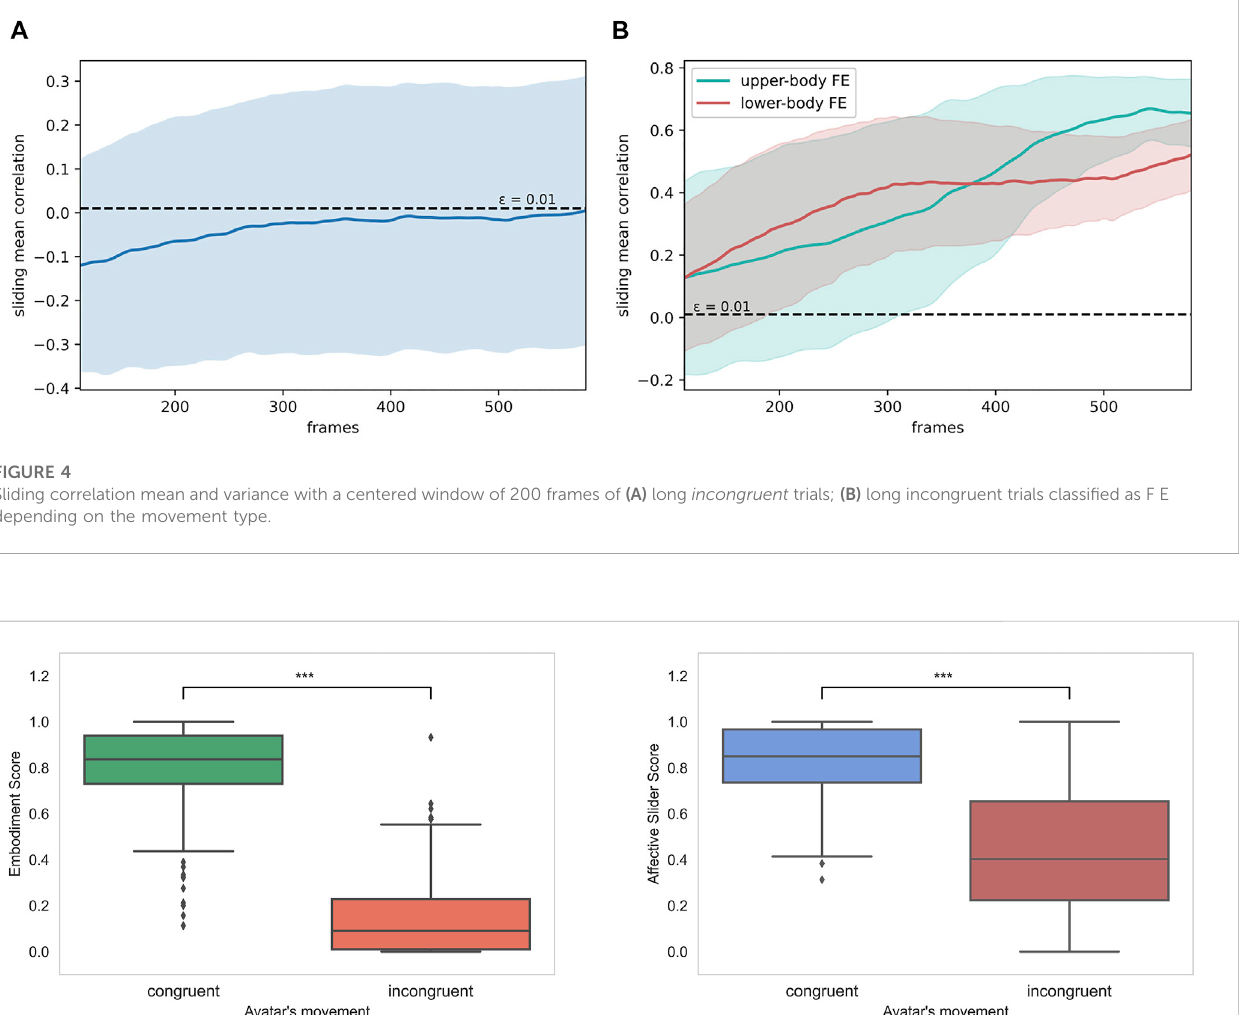
FIGURE 5 Sense of embodiment scores (left) and affective slider results (right) depending on the avatar ’ s movement congruency.